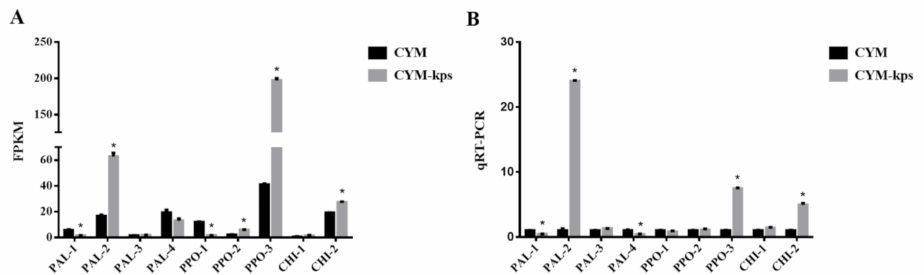
Figure 5. Transcript levels of the homologous genes encoding key enzymes involved in the flavonoid biosynthesis pathway in A. cornea. ( A ) transcriptome data (FPKM), ( B ) relative gene expression levels (qRT-PCR). Error bars indicate the standard deviations across three independent samples; FPKM, expected number of fragments per kilobase of transcript sequence per million base pairs sequenced; CYM, complete yeast medium as the control group; CYM-kps, CYM medium with leachate of Korshinsk peashrub ( Caragana korshinskii ) at a concentration of 75 g/L; qRT-PCR, quantitative real- time polymerase chain reaction; * indicates statistical significance ( p < 0.05) compared to the